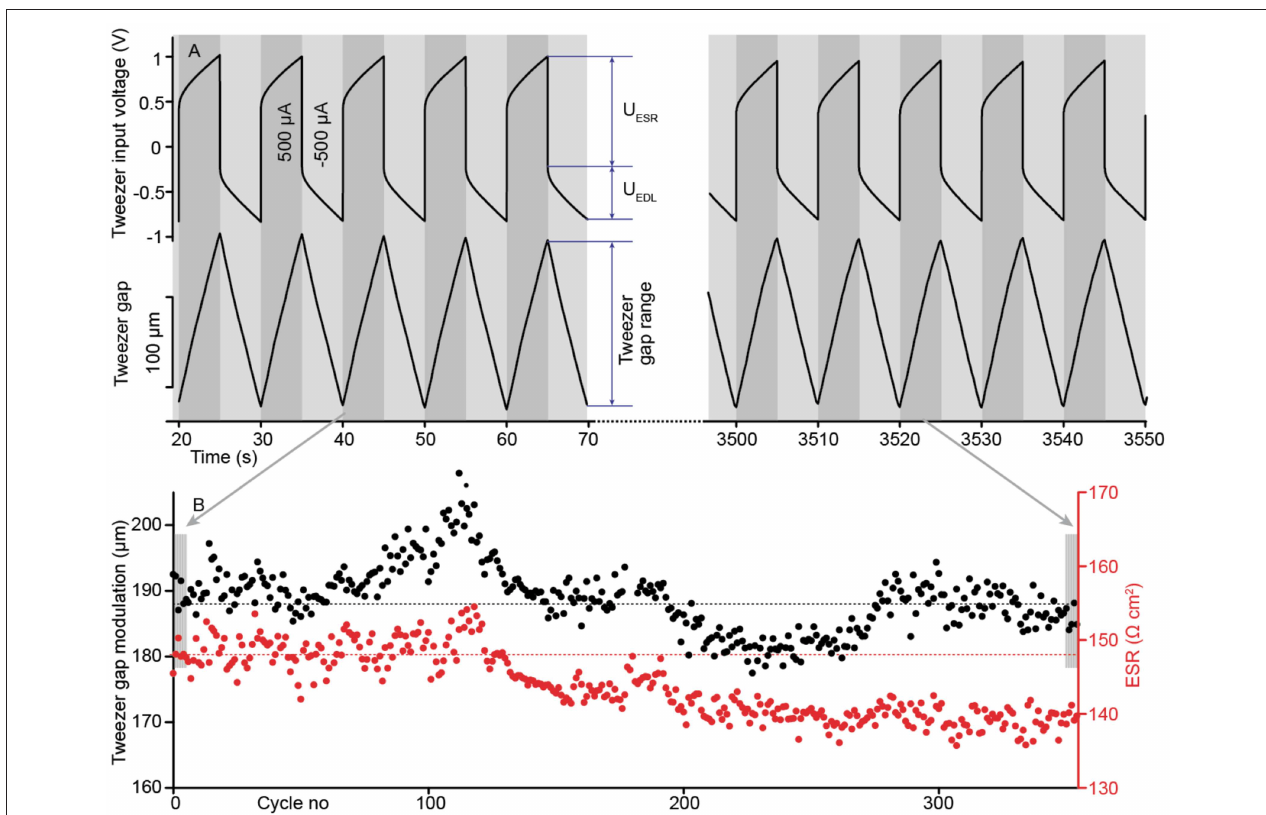
FIGURE 8 | (A) Repeatable pattern of the tweezer gap and the corresponding transient voltage, showing the contribution of the equivalent series resistance (ESR). (B) Tweezer lifetime and ESR during 350 actuation